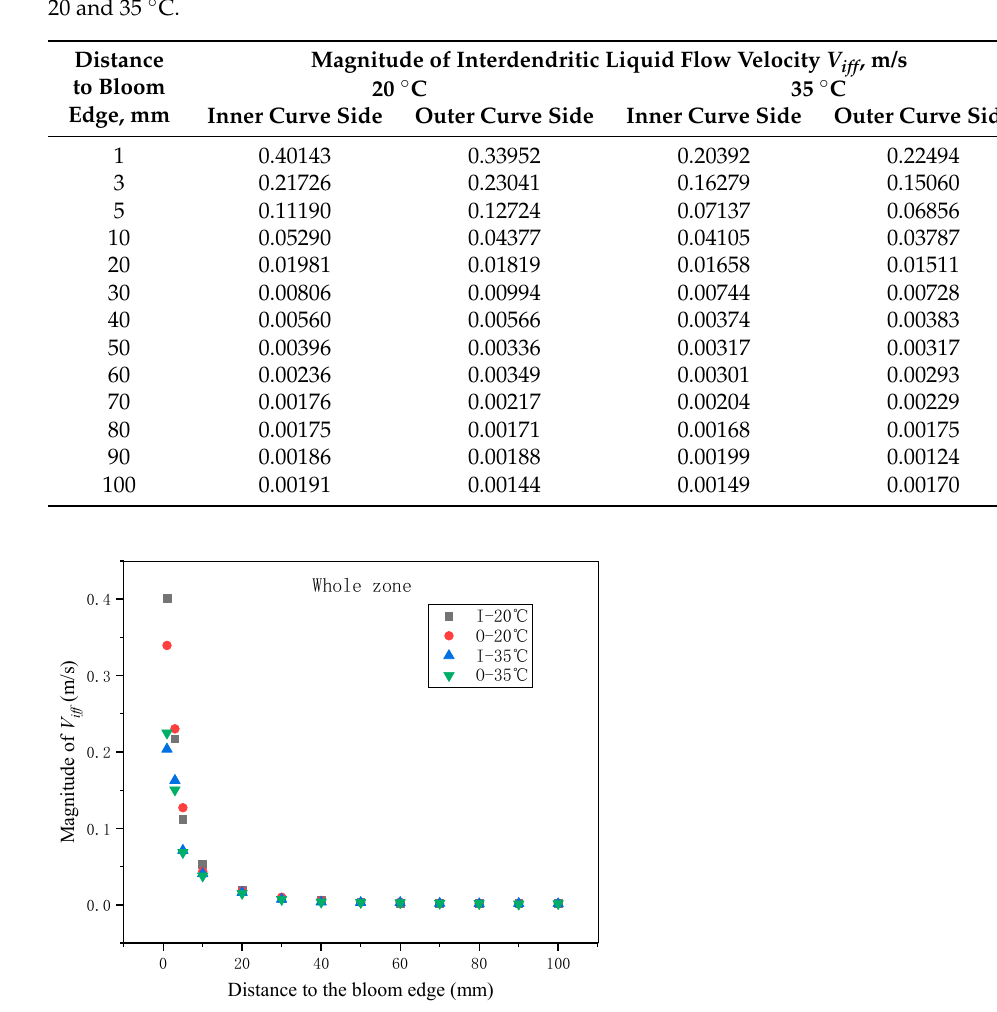
Figure 17. Average value and standard deviation of interdendritic fluid flow velocity iff V magnitude of middle and central zones in the inner curve side and the outer curve side under 20 °C and 35 °C : ( a ) average value, ( b ) standard deviation.